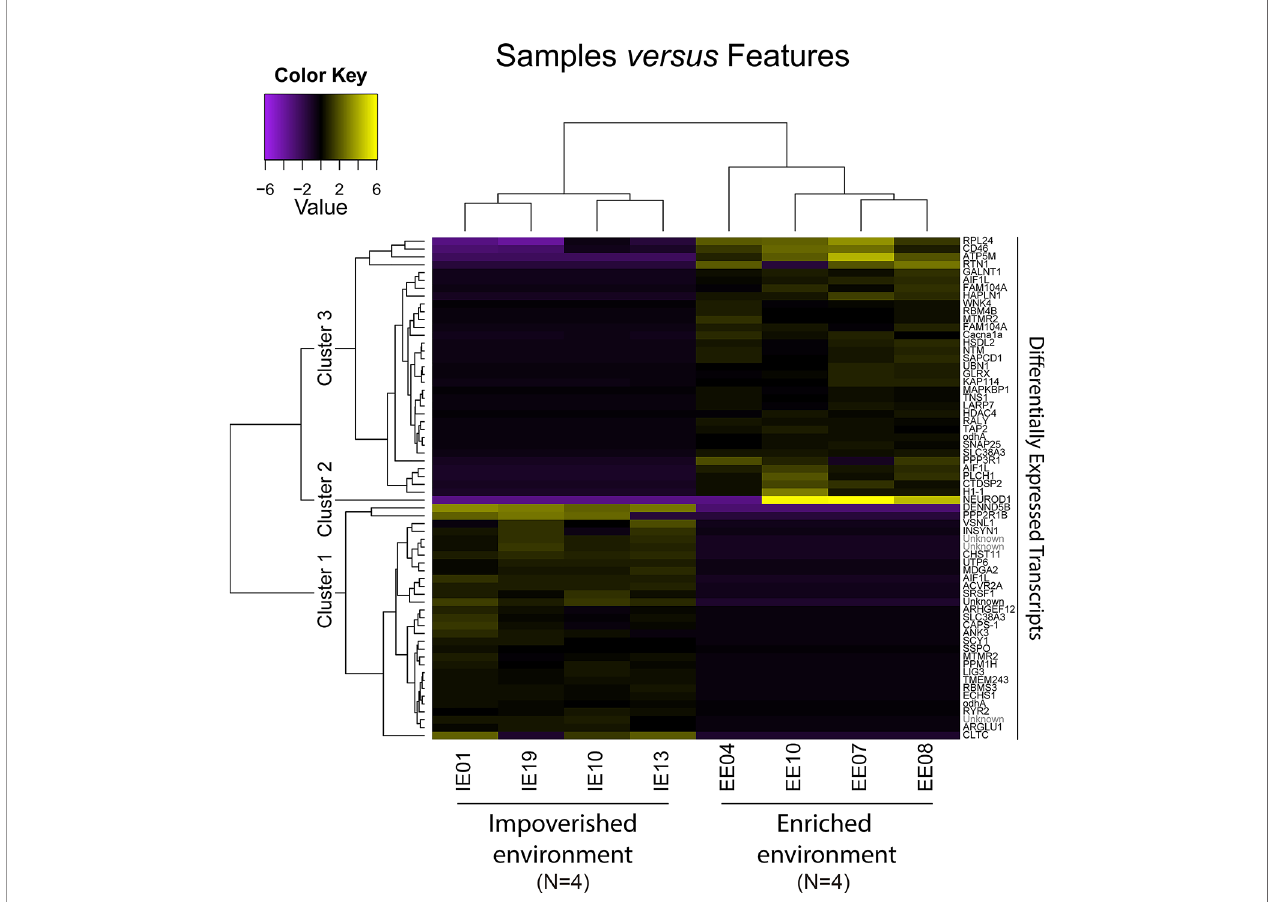
FIGURE 9 | Heatmap from 64 differentially expressed transcripts from C. macropomum individuals. Yellow indicates upregulated and purple downregulated transcripts. The upper cladogram represents a cluster analysis between individuals based on transcript expression, and the left cladogram shows the cluster analysis between each transcript. Three main clusters of transcripts with distinct expression pro fi les are indicated. On the right is the transcript annotation according to best BLAST hit (see Table S8.xlsx ). “ Differentially expressed transcripts ”